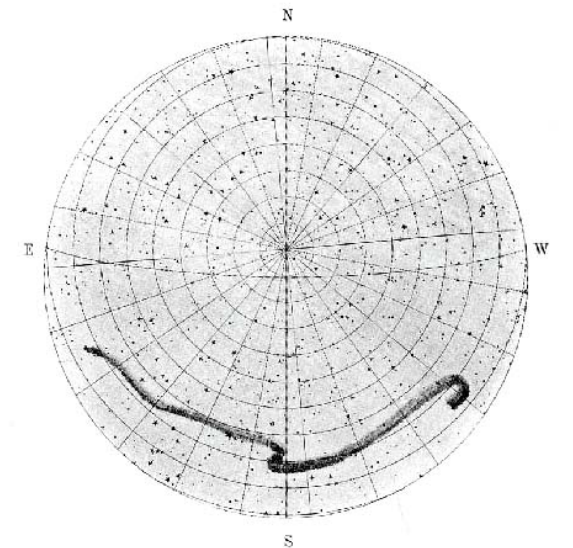
Fig. 17. All-sky drawing of aurora at Treurenberg Bay on 28 Jan- uary 1900 at 17:42 UT. At the same time the aurora at Konstanti- novka was described in the following way: “17:42 UT. An auroral band like a snake was situated from East to West. Circulation of luminosity inside the band is varied from West to East to East to West. Intensity: 2.”